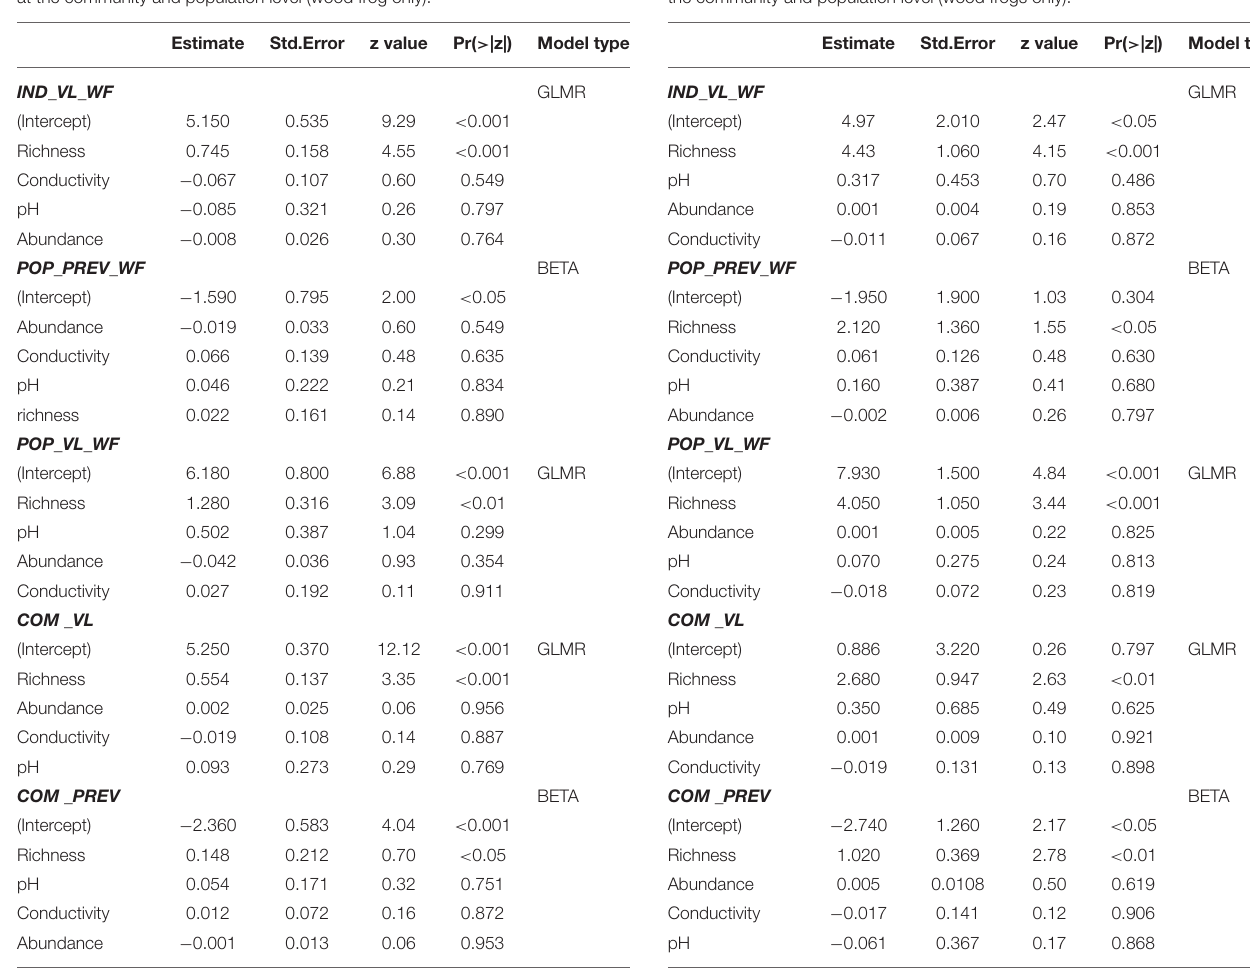
TABLE 6 | Generalized linear mixed model (GLMR) and beta regression (BETA) results for ranavirus prevalence and viral loads in aquatic amphibian life stages at the community and population level (wood frogs